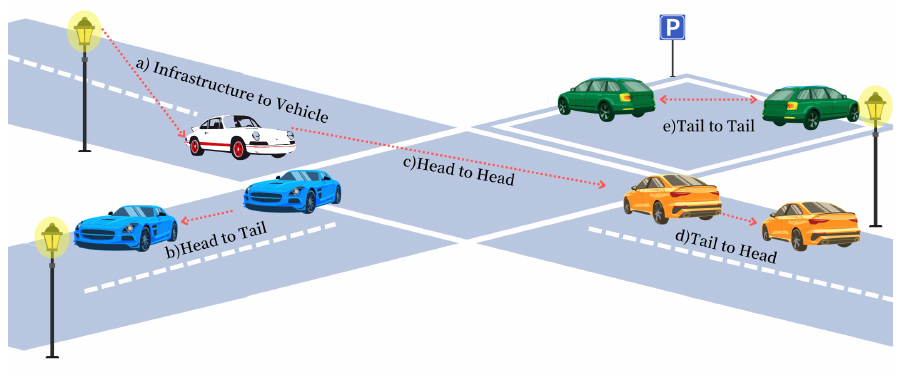
Figure 6. A typical V-VLC traffic scenario.